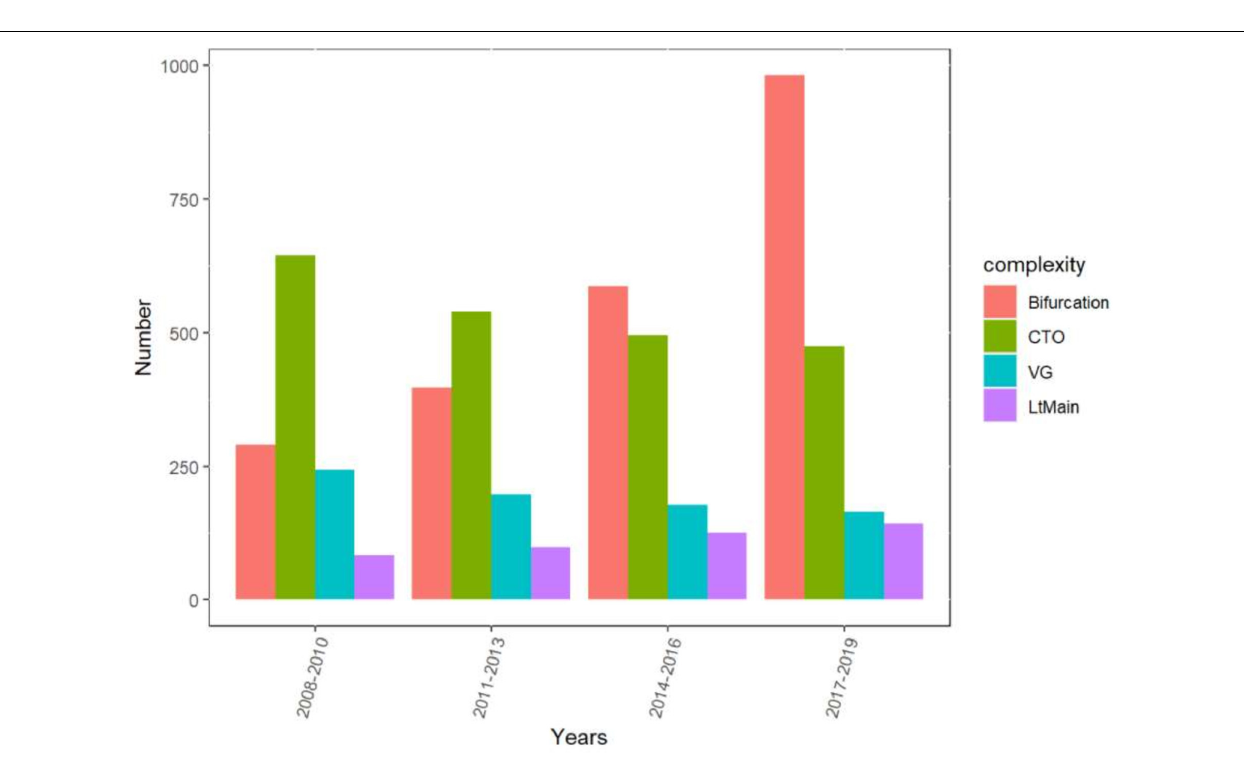
FIGURE 2 | Interventions grouped by time period and complexity